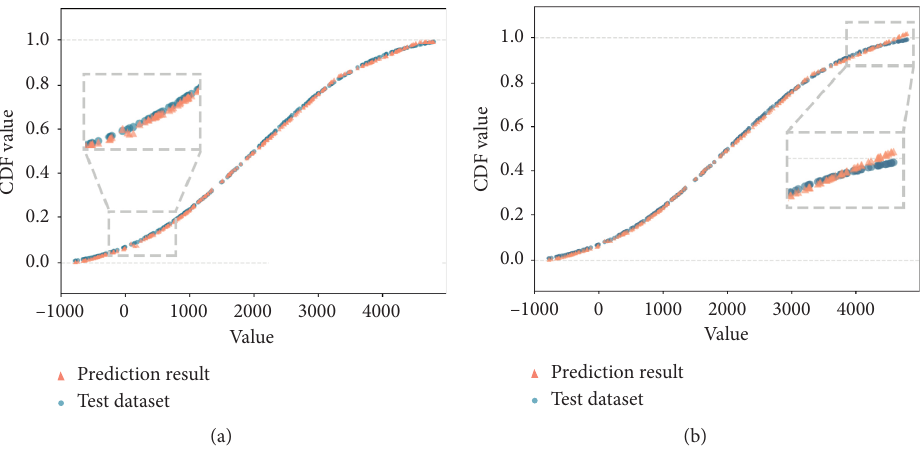
Figure 1: Illustration of two examples violating the monotonicity (a) and boundedness (b) properties of CDF, respectively. In both plots, the x -axis presents the values of unsorted elements in the test dataset and the y -axis represents the values of CDF. In a plot, the pink triangle- shaped points depict the CDF values predicted by a BP neural network, the blue points present the true CDF values of unsorted elements in the test dataset, and the lower and upper gray lines are the lower and upper bounds of the CDF (i.e., 0 and 1), respectively.